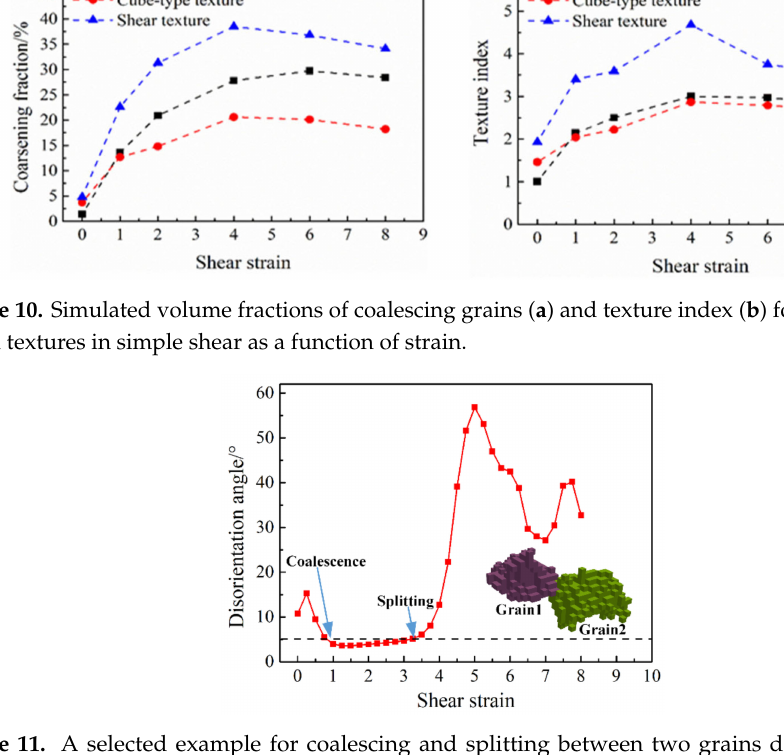
Figure 11. A selected example for coalescing and splitting between two grains displayed by the evolution of their disorientation.